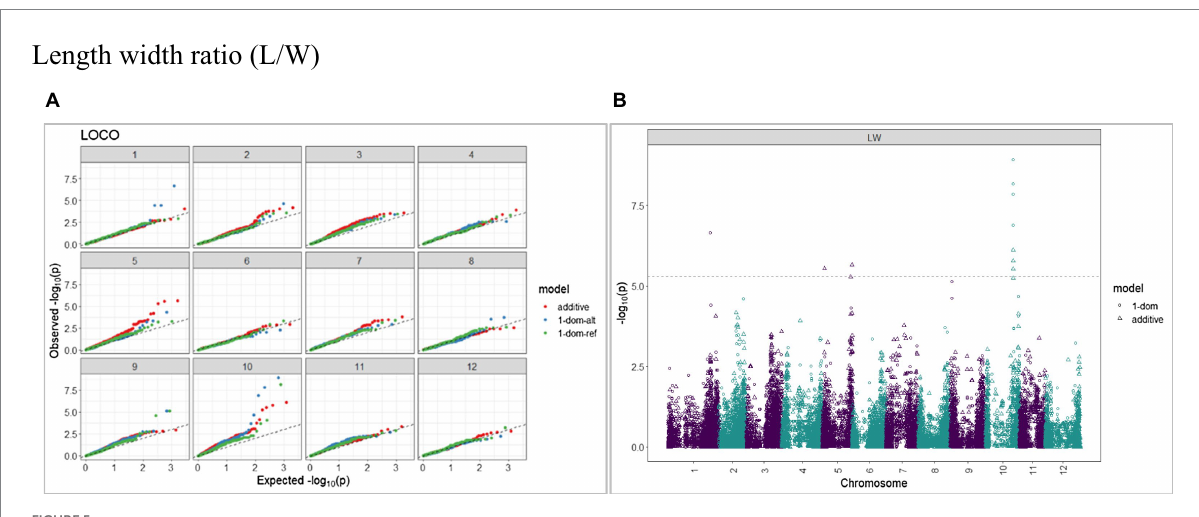
FIGURE 5 Q–Q plots of observed vs. expected -log10 ( p values) ( A ) and corresponding Manhattan plot (B) for length–width ratio (L/W) using the additive and dominant model for tuber traits of 214 potato clones evaluated in three environments in Texas: Dalhart 2019, 2020 and Springlake 2020. The Bonferroni threshold is at 5.3 for the additive, 5.0 for 1-dom-alt, and 5.1 for the 1-dom-ref